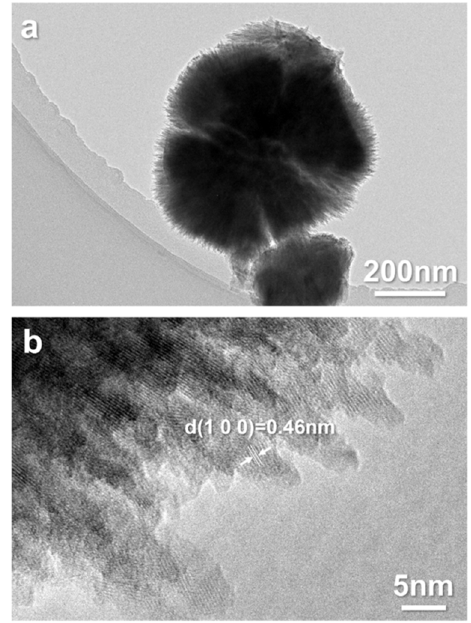
Figure 4. ( a ) Low-magnification and ( b ) high-resolution TEM image of the nanoparticles on the HGM-RC microbead